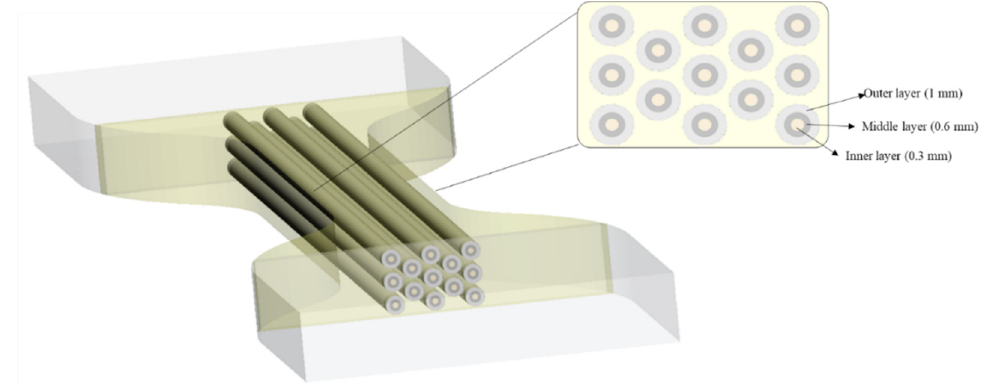
Figure 7. Bamboo-Like (BL) pattern arrangement. In a cross-sectional view, the dimensions of each layer are reported. Table 3. Shore A hardness values were assigned for each layer of the Bamboo-Like (BL) pattern. The range considered was from 50 (medium-soft) to 70 (hard-soft).